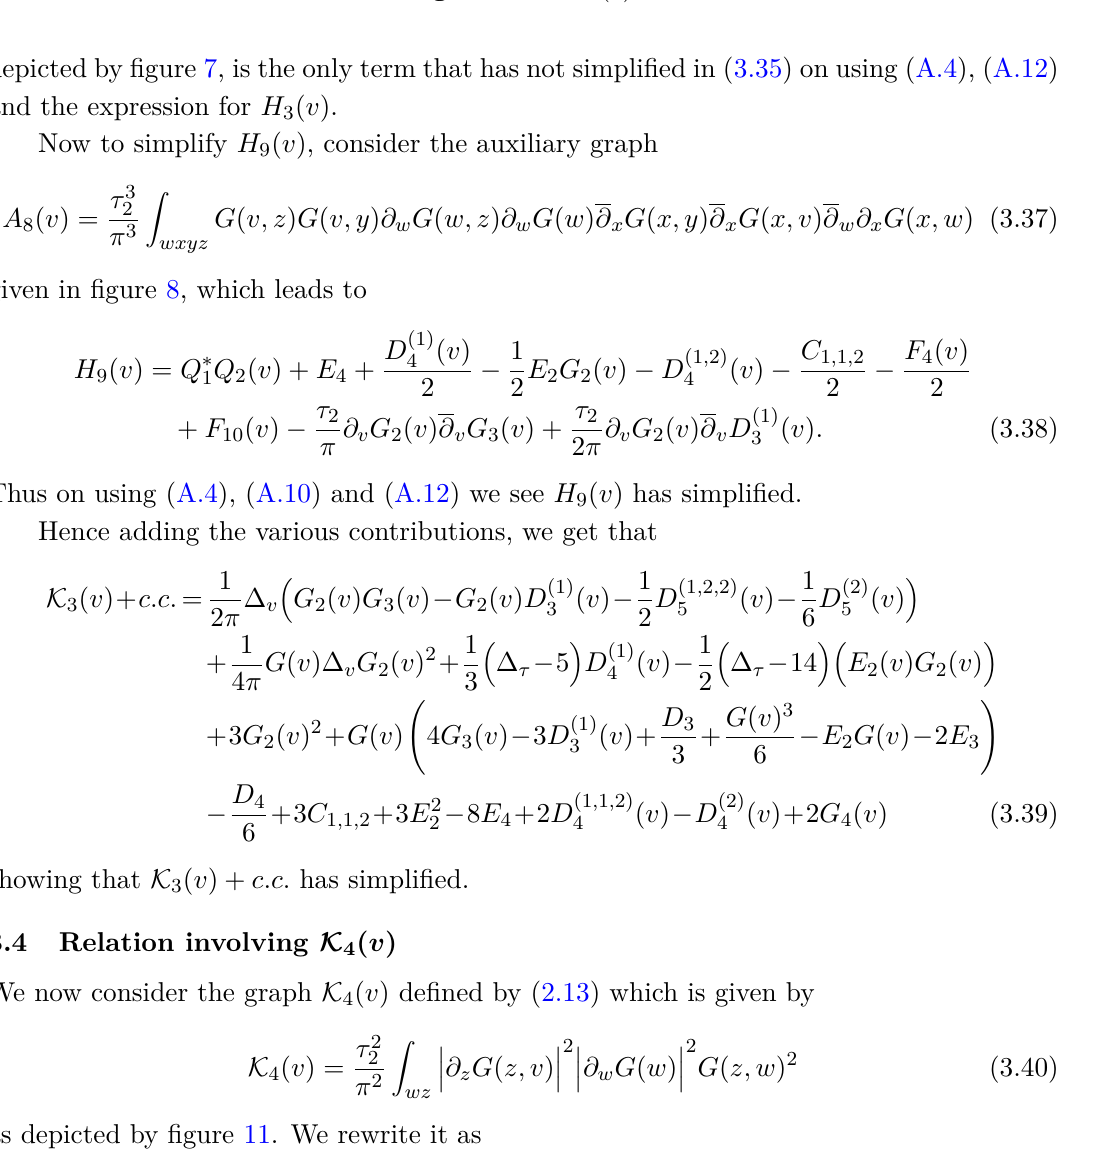
Figure 11 . π 2 K 4 ( v )